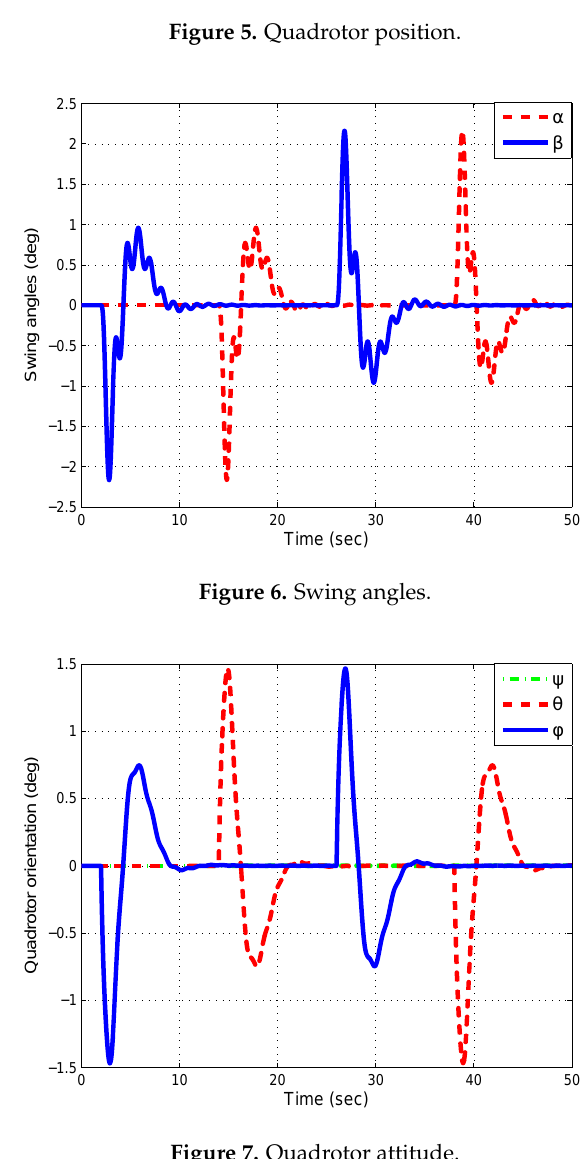
Figure 7. Quadrotor